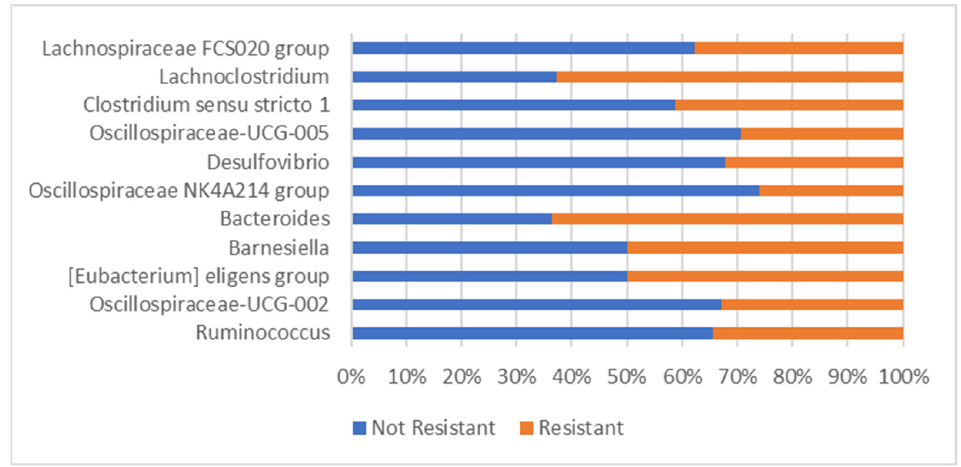
Figure 4. Median abundances for the most significant genera in resistant and non-resistant groups.